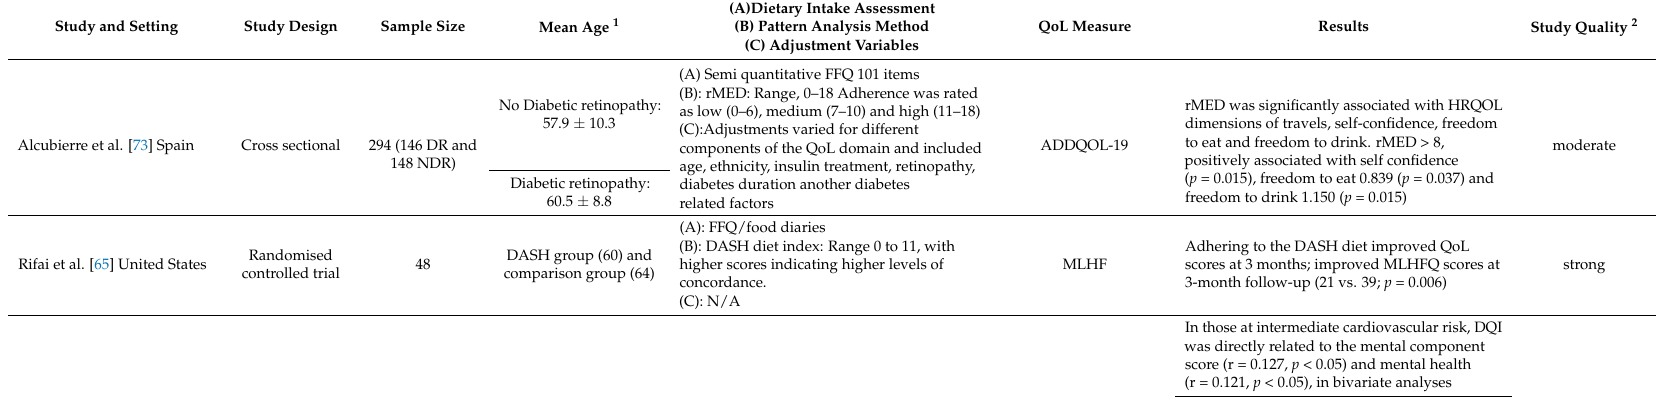
Inthoseatintermediatecardiovascularrisk,DQI was directly related to the mental component score (r = 0.127, p < 0.05) and mental health (r = 0.121, p < 0.05), in bivariate analyses moderateGreater adherence to the Mediterranean diet was associated with higher scores on the SF-12 mental component, social functioning and vitalityand DQIshowed anassociation withthe mental component score. Spanish version of the Bivariate correlation: The Mediterranean Diet SF-12 v.2 (total score) was related to the mental component (r = 0.164, p < 0.01) as well as social functioning (r = 0.172, p < 0.01) and vitality (r = 0.122, p <0.05). Multiplelinearregression: 1.177 pointincrease inthe mentalcomponent foreach increase of 1 point in the Mediterranean diet adherence score ( p < 0.01), Vitality ( β = 0.958 and0.990)andSocialFunctioning( p <0.05and p < 0.01) domains maintained association post adjustments.